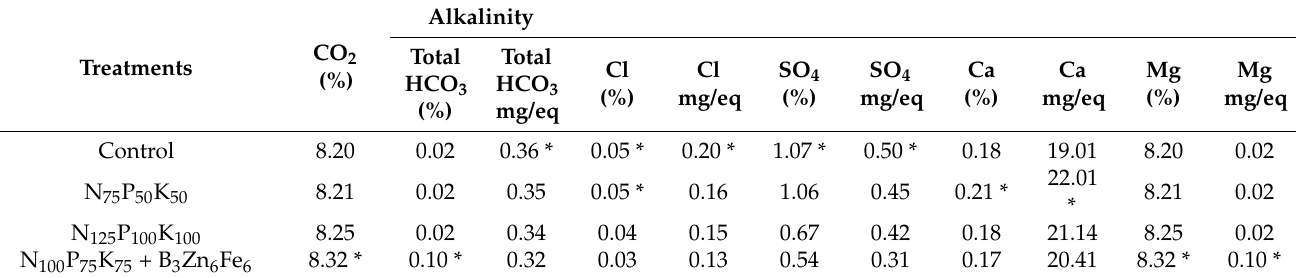
Table 6. The effect of mineral fertilisers on chemical properties of irrigated soil in the Kibray district.